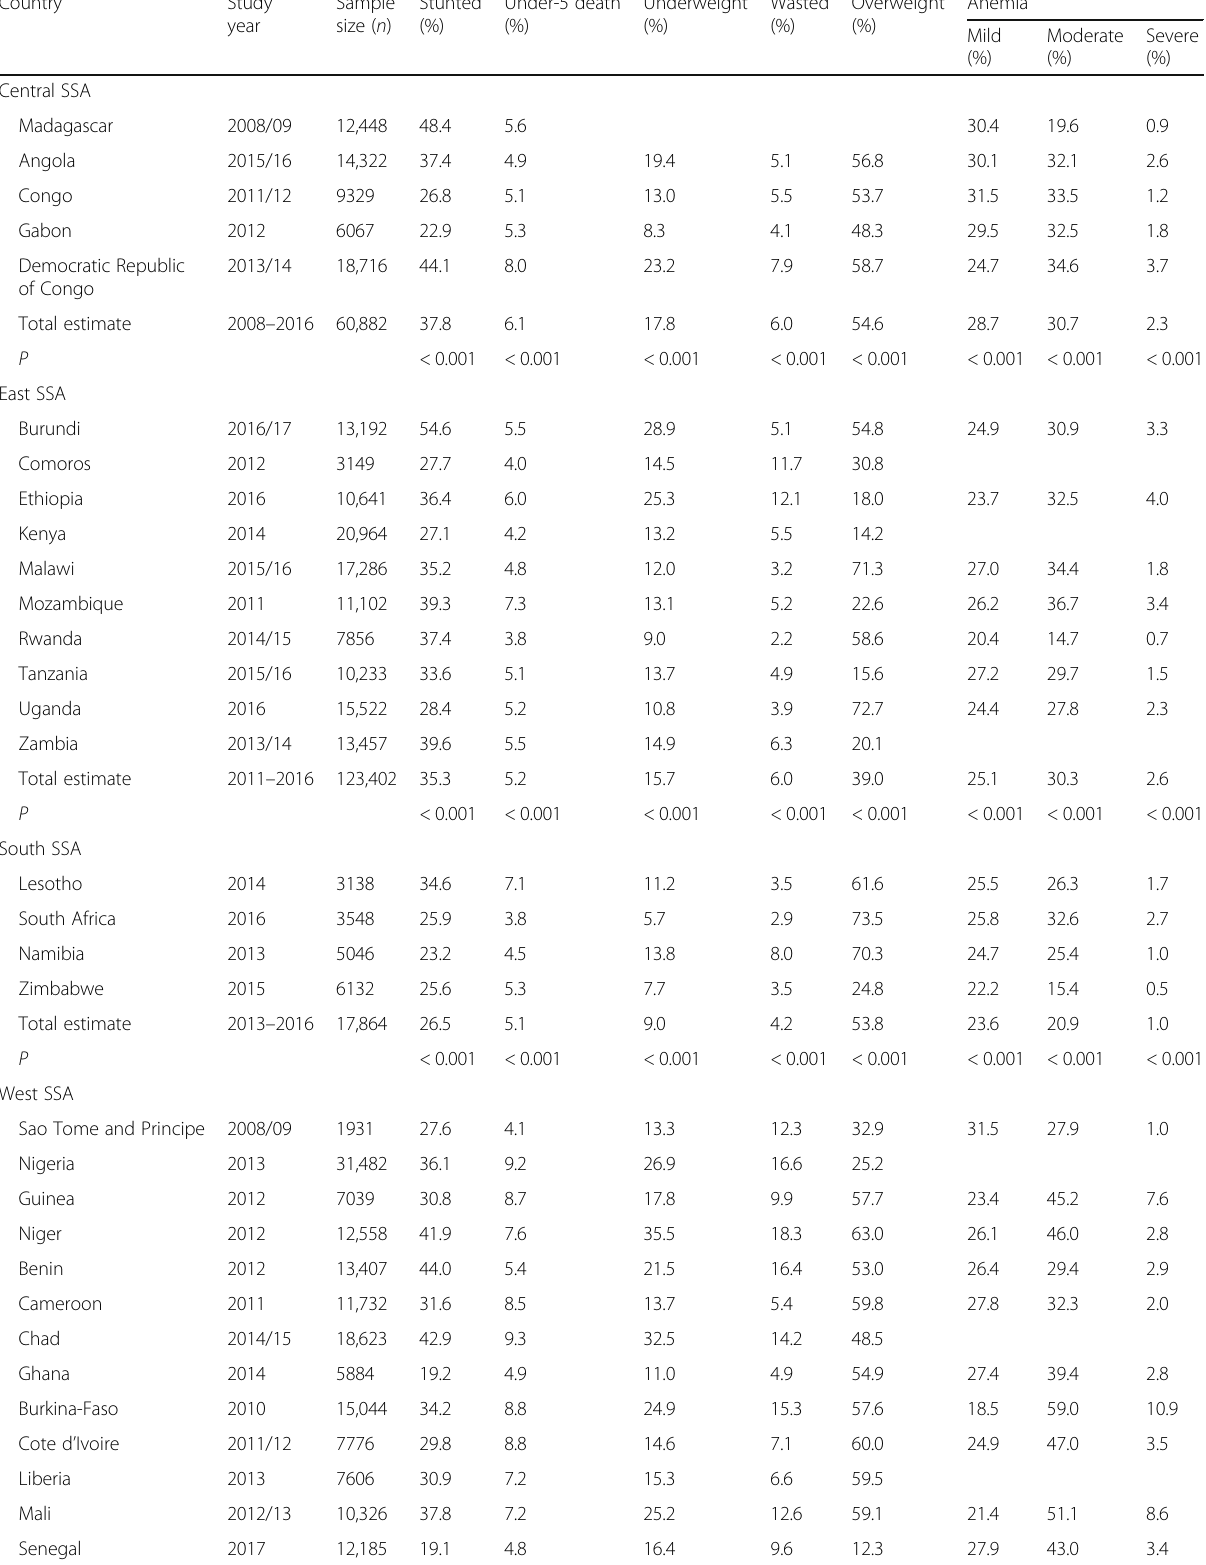
Table 1 Summary statistics from 35 SSA countries on nutrition indicators among under-five children; DHS, 2008-2017 Country Study